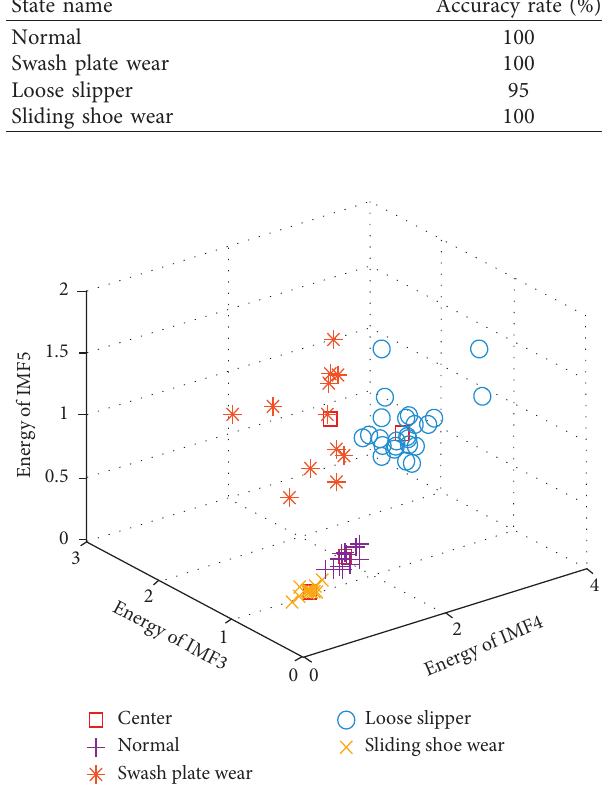
Figure 20: Clustering results by use of EMD combined with energy